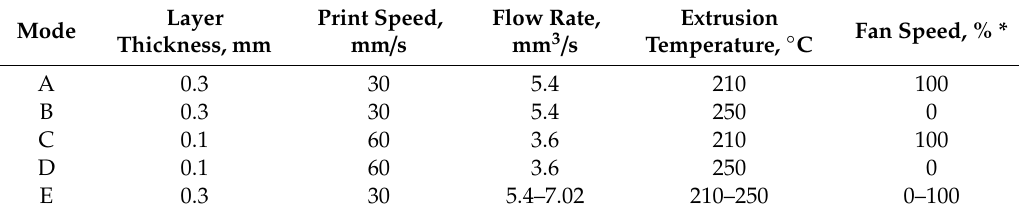
Table 1. Printing modes of samples